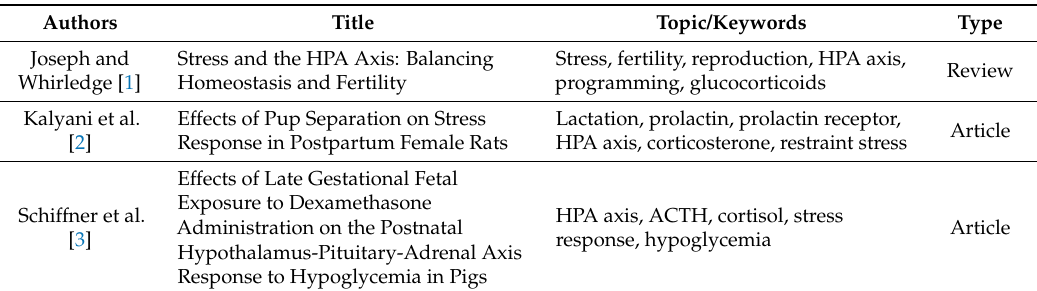
Table 1. Summary of the papers in this Special